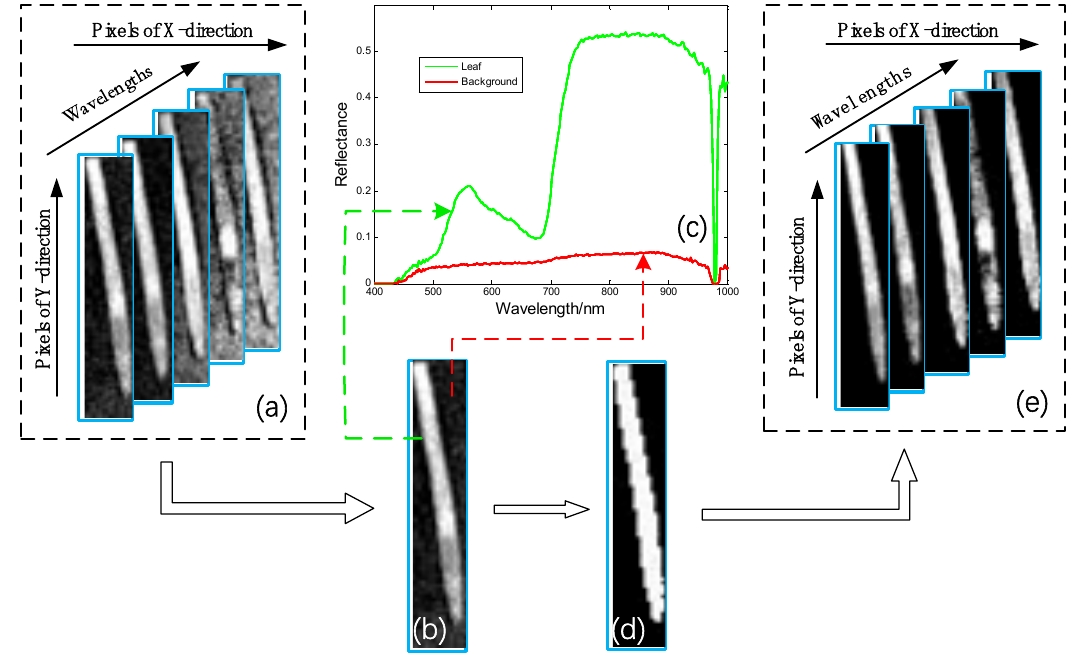
Figure 2. Procedure for image segmentation.